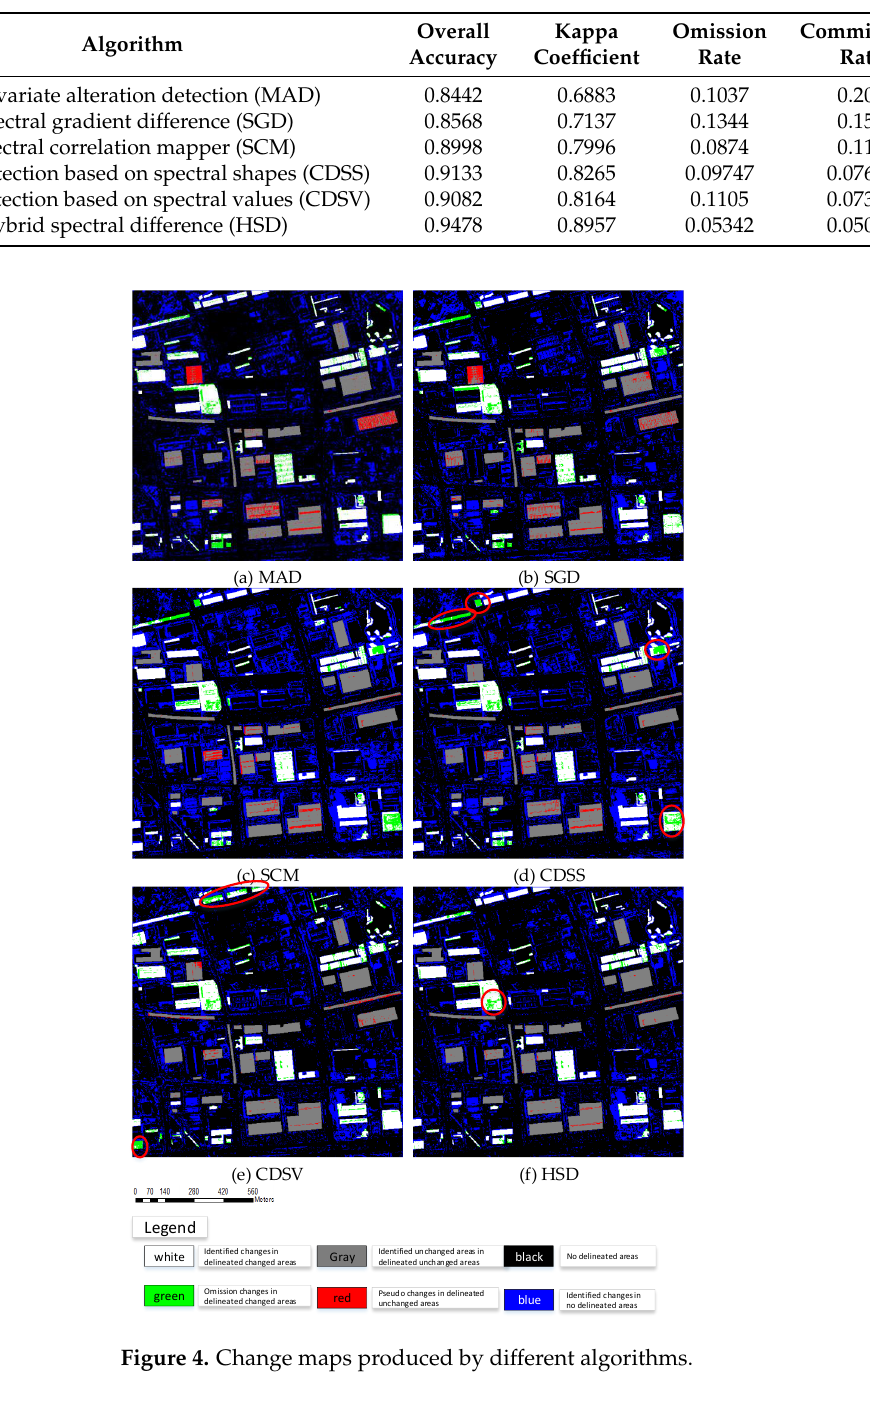
Table 2. The values of the accuracy features and the thresholds of different algorithms when they got their highest kappa coefficients.